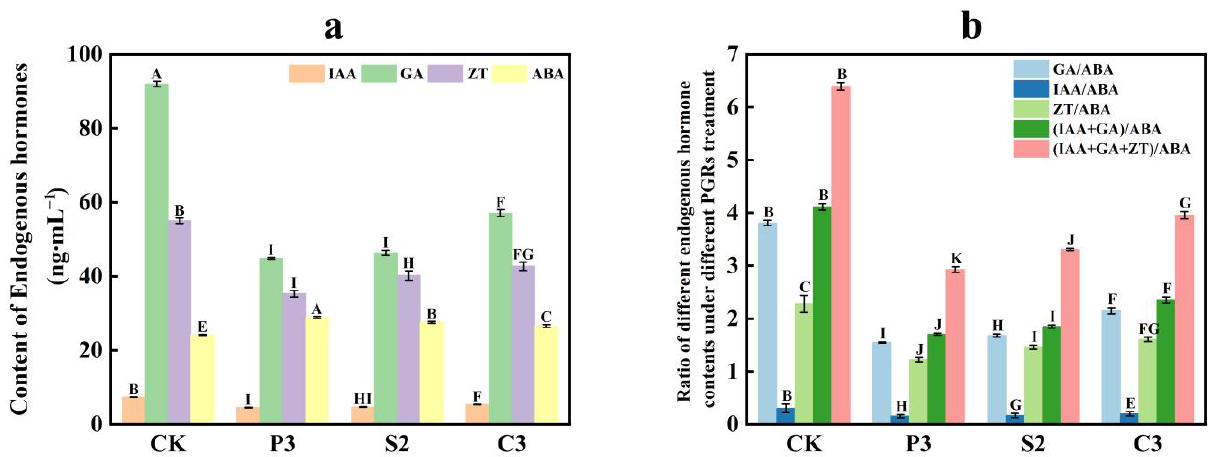
Figure 7. Effects of PGRs on endogenous hormones of M. alternifolia. ( a ) Effect of PGRs on endogenous hormone content of M. alternifolia , ( b ) ratio of different endogenous hormone contents in M. alternifolia leaves treated with PGRs. Note: different letters followed the mean indicate significance at p < 0.01 according to Duncan’s multiple range test.